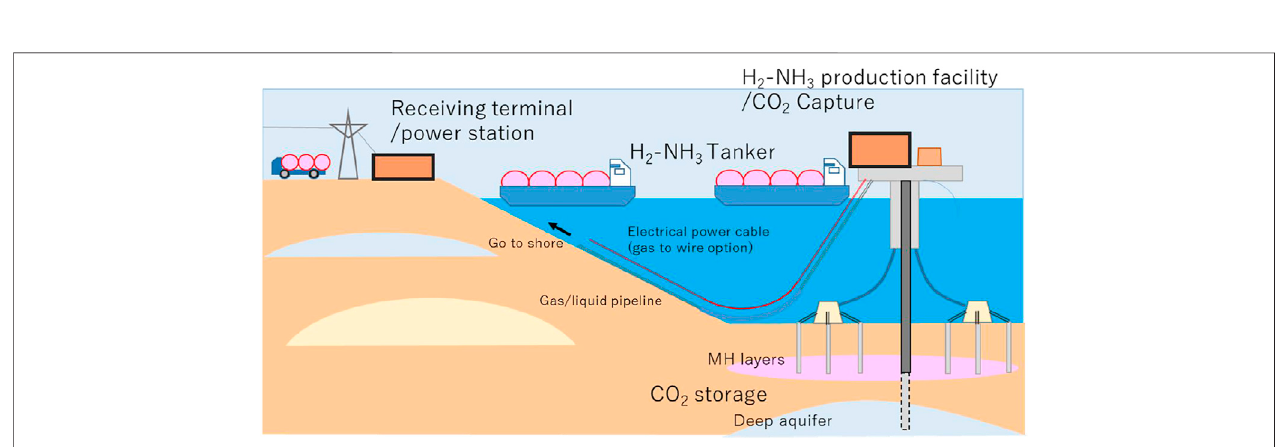
FIGURE11 | Schematic of theintegration ofoffshore gas hydrate production, energy conversion, and CCS (modi fi ed from Yamamoto et al., 2021b).There can be options to transport converted fuels from offshore to land by pipelines or as electricity (gas-to-wire, GTW).